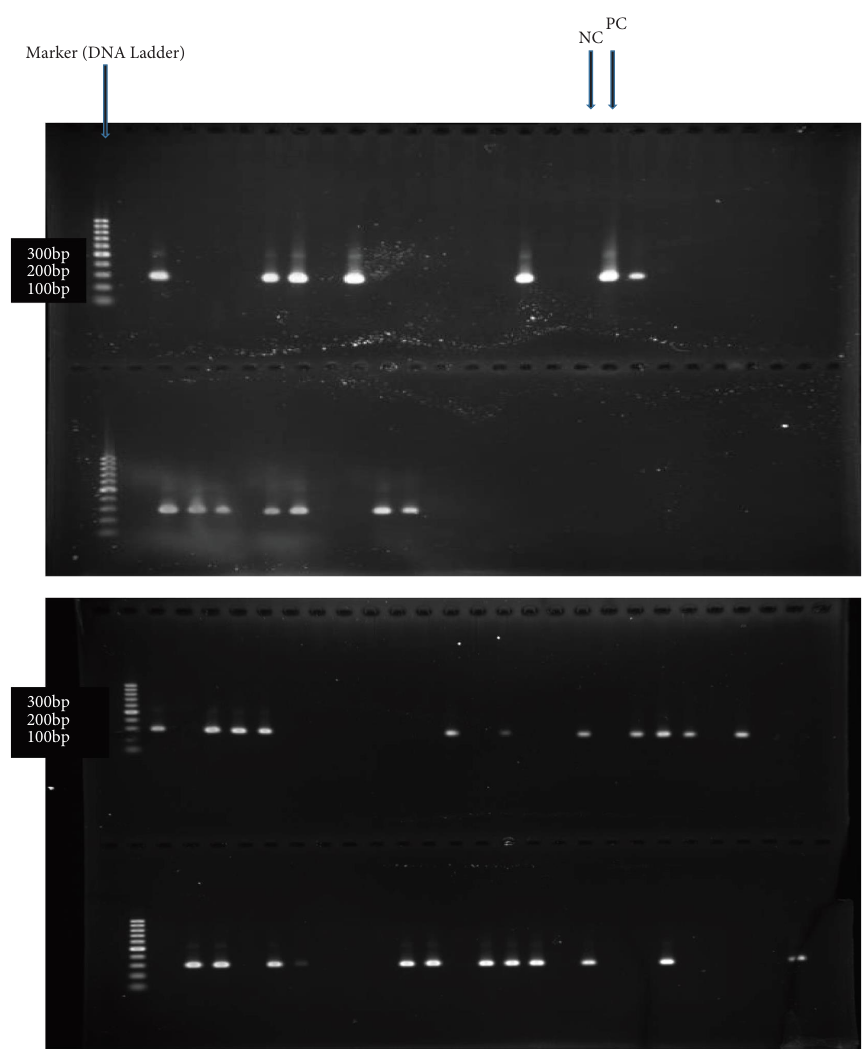
Figure 1: Agarose gel electrophoresis represents 300bp bla NDM-1 gene in Acinetobacter Species (Amplicon size-300